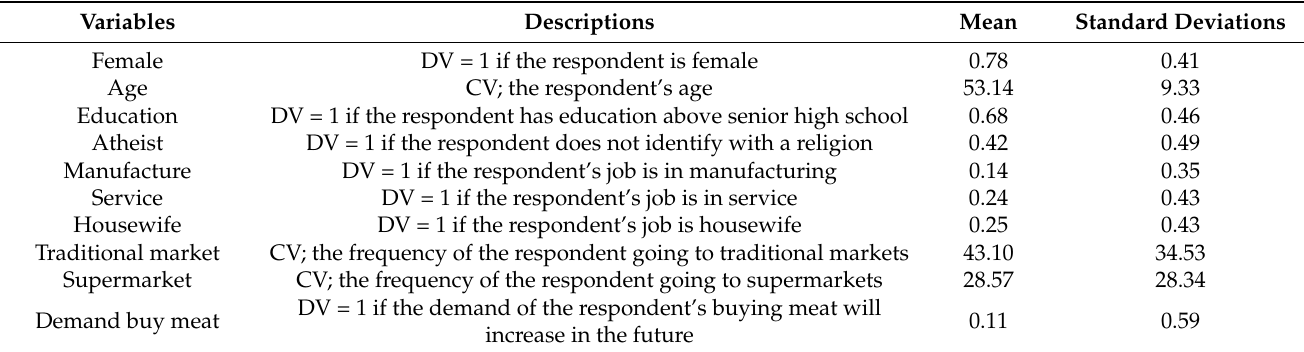
Table 2. Definitions and sample statistics of variables ( n =